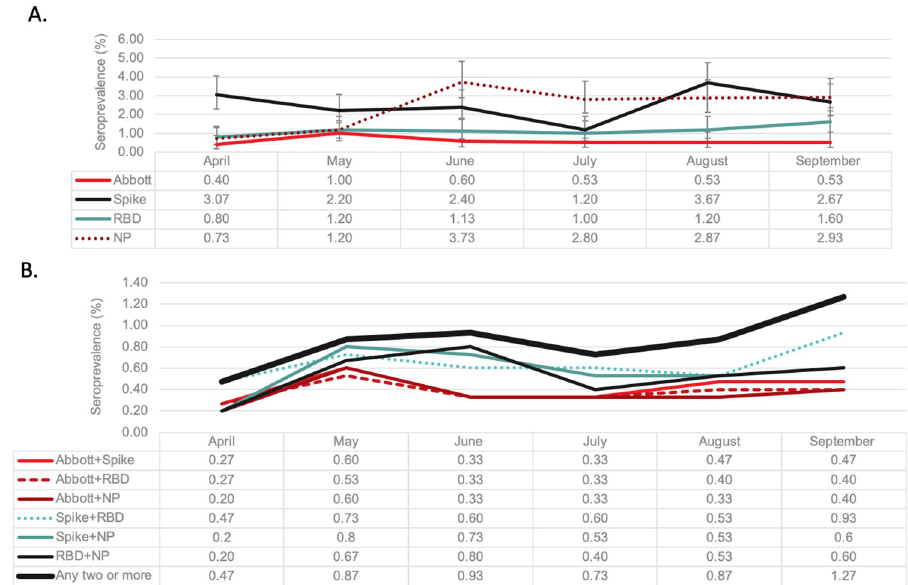
Fig 1. A . Seroprevalence by month over the first COVID-19 wave in Canada by individual assays. Each line represents seroprevalence rates (summarized in table below) monthly between April and September 2020 (during the first COVID-19 Wave) based thresholds for each assay. Abbott Architect SARS-Cov-2 IgG assay (Abbott-NP) and three in- house IgG ELISA assays recognizing distinct recombinant viral antigens: full length spike glycoprotein (Spike), spike glycoprotein receptor binding domain (RBD), and nucleocapsid (NP). B . Seroprevalence by month over the first COVID-19 wave in Canada by various composite reference standards (results from four anti-SARS-CoV-2 immunoassays). Each line represents seroprevalence rates based on predefined definitions. CRS based on a combination of reactive samples using Abbott-NP, Spike, RBD and NP. Positivity based on “any two or more” was determined by a reactive sample from two or more assays. Since we are not comparing CRS, we did not include 95% CI for each data point (all overlapping).